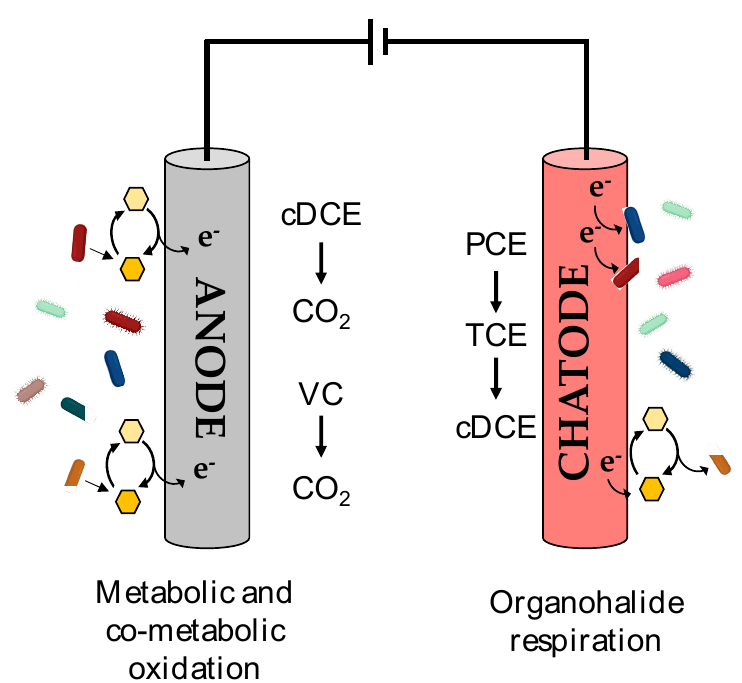
Figure 6. Illustration of a bioelectrochemical cell with aerobic and anaerobic biotransformation of chloroethene mechanisms.